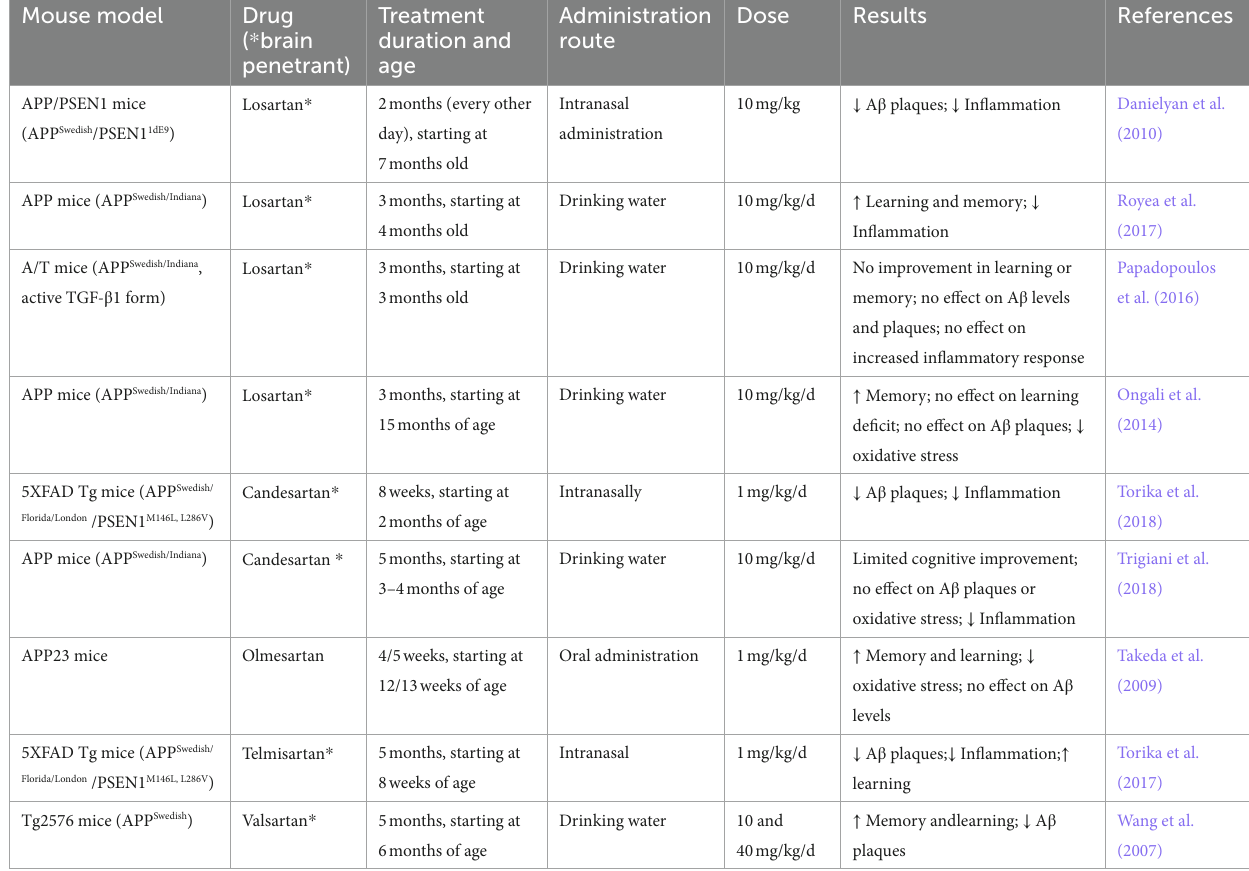
TABLE 1 Summary of effects of ARBs in mouse models of AD including A β levels and deposition, neuroinflammation and oxidative stress and, cognitive deficits. Mouse